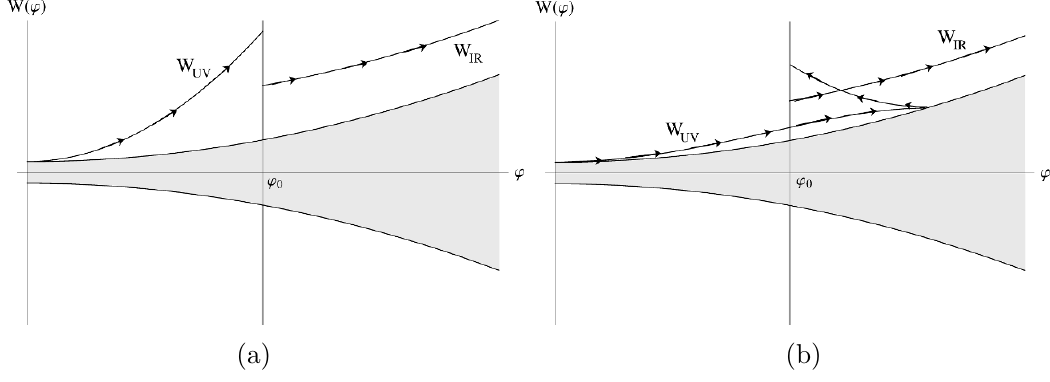
Figure 16 . Sketch of the global behavior of the superpotential in case A 1, when W B < 0. The left (cid:12)gure corresponds to the case W 0 ( ’ 0 ) > 0, whereas the right (cid:12)gure corresponds to W 0 UV 0. In the former case, the UV solution connects directly to the (cid:12)xed point at ’ = 0. In the latter, it continues past ’ 0 and goes to the UV (cid:12)xed point after a bounce at some ’ > ’ 0 . The shaded area corresponds to the forbidden region (cid:0) B ( ’ ) < W ( ’ ) < B ( ’ ), where B ( ’ ) is de(cid:12)ned in equation (A.2).